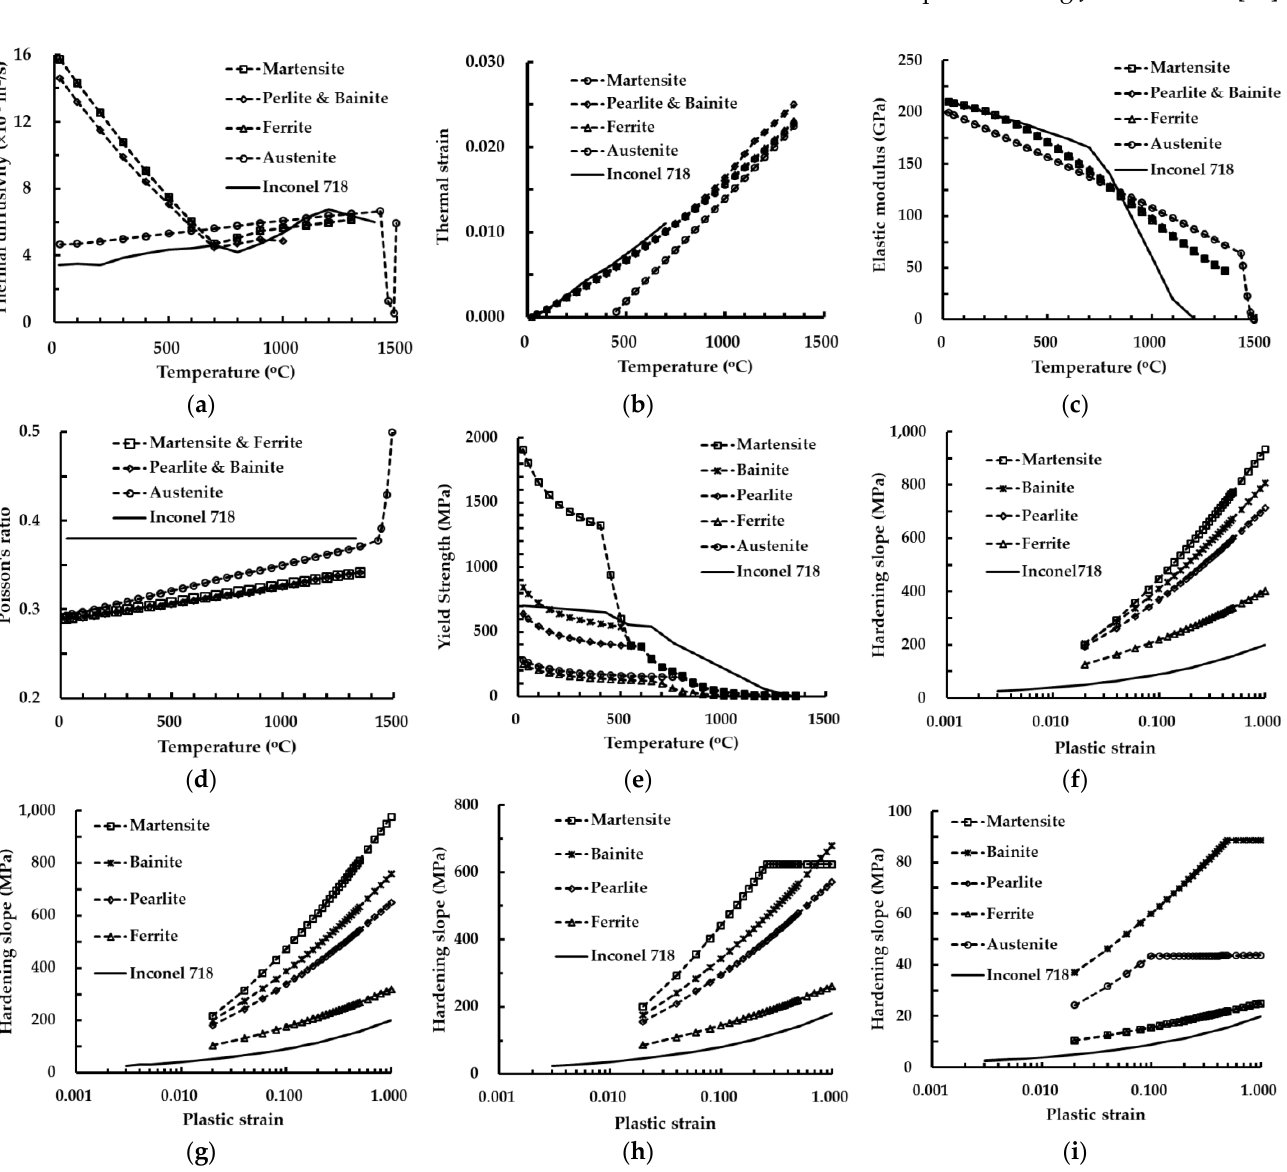
( k ) Figure 4. Thermal and mechanical properties of Inconel 718 and AISI 1045 [34,38]: ( a ) thermal diffusivity; ( b ) thermal strain; ( c ) elastic modulus; ( d ) Poisson’s ratio; ( e ) yield strength; ( f ) hardening slope—plastic strain curve (room tempera- ture); ( g ) hardening slope—plastic strain curve (temperature = 200 °C); ( h ) hardening slope—plastic strain curve (temper- ature = 400 °C); (i) hardening slope—plastic strain curve (temperature = 800 °C); ( j ) hardening slope—plastic strain curve (temperature = 1200 °C); ( k ) continuous cooling transformation (CCT) diagram of AISI 1045.